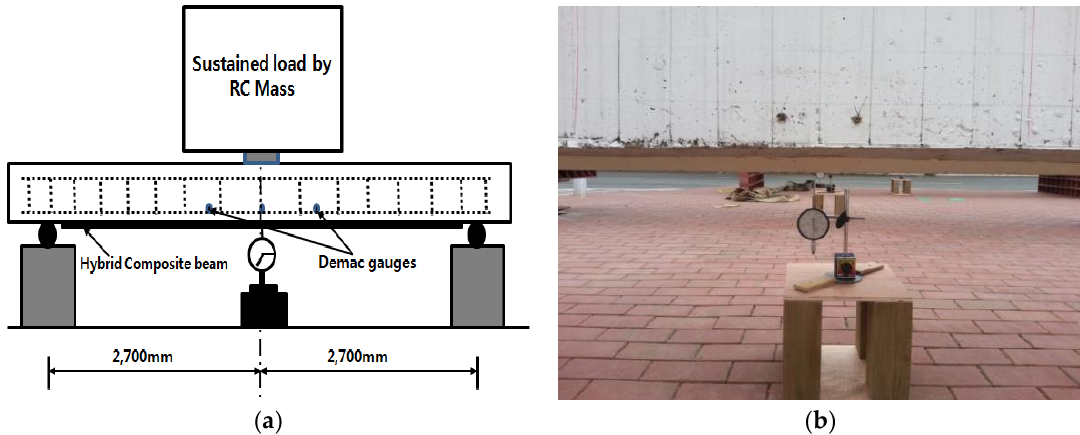
Figure 5. Schematic test setup and creep measurement: ( a ) schematic test setup; ( b ) measurement.